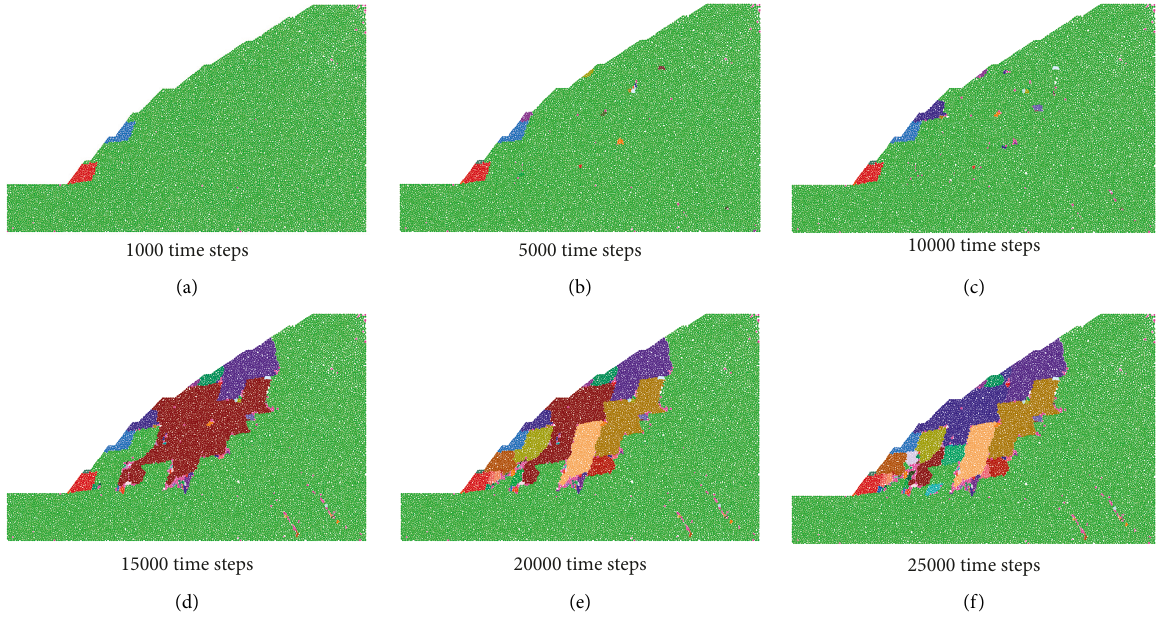
Figure 9: The spatiotemporal development process of the ruptured block: (a) 1,000 time steps, (b) 5,000 time steps, (c) 10,000 time steps, (d) 15,000 time steps, (e) 20,000 time steps, and (f) 25,000 time